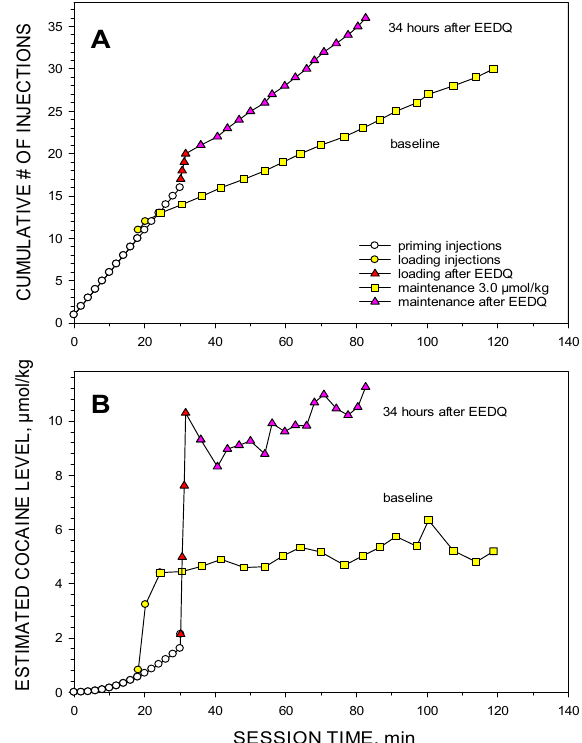
Figure 3. The effect of EEDQ on cocaine self-administration. The panels are two representative sessions from the same rat before (yellow squares) and 34 h after (pink triangles) EEDQ injection. Panel ( A ) shows the cumulative number of injections over session time, while Panel ( B ) shows the calculated cocaine level in the rat at the time of each